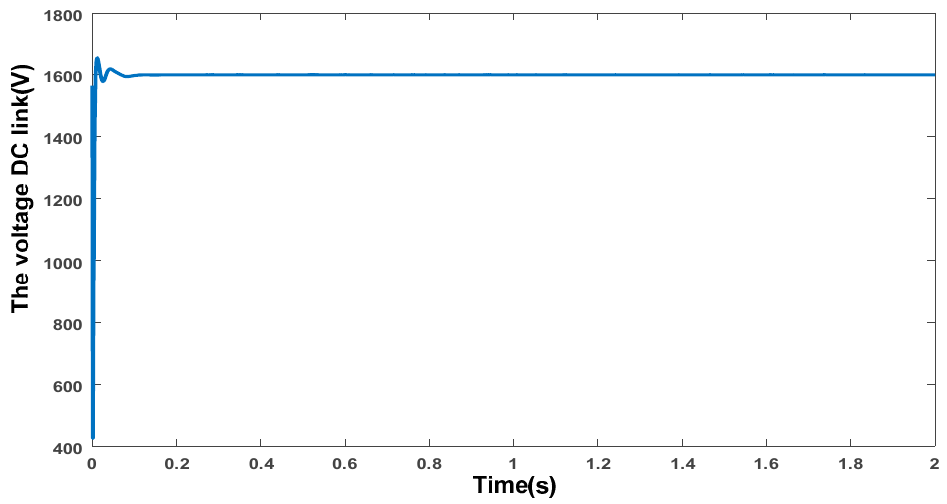
Figure 23. The voltage and current at the grid side with an imbalanced load with MMC STATCOM.